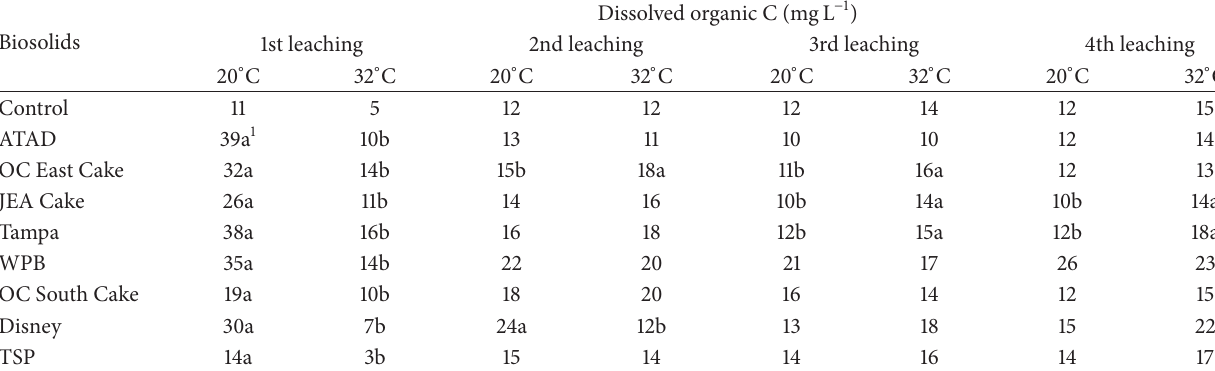
Figure 3: Changes in WEP concentrations as affected by incubation period and temperature. Table 3: Leachate dissolved organic C